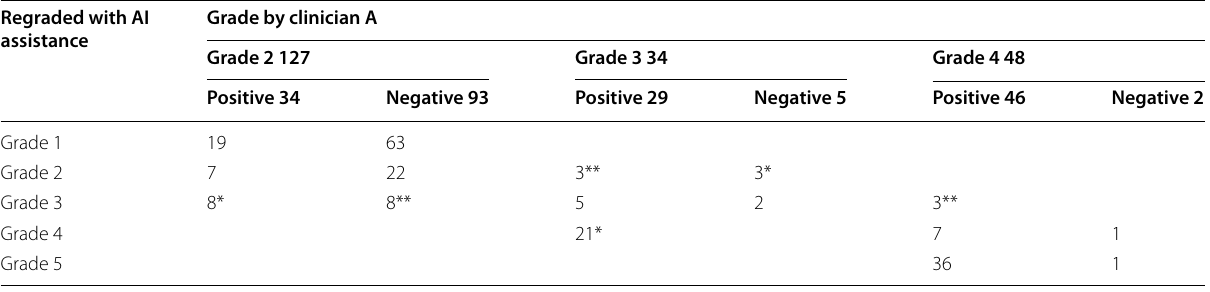
‘*’ denotes diagnoses corrected by the AI assistance including (1) false-positive and false-negative samples reconsidered as grade 3, and (2) samples of grade 3 reconsidered correctly as grade 2 or grade 4 ‘**’ denotes mistakenly reconsidered diagnoses including (1) true-positive and true-negative samples reconsidered as grade 3, and (2) grade 3 samples reconsidered mistakenly as grade 2 or grade 4